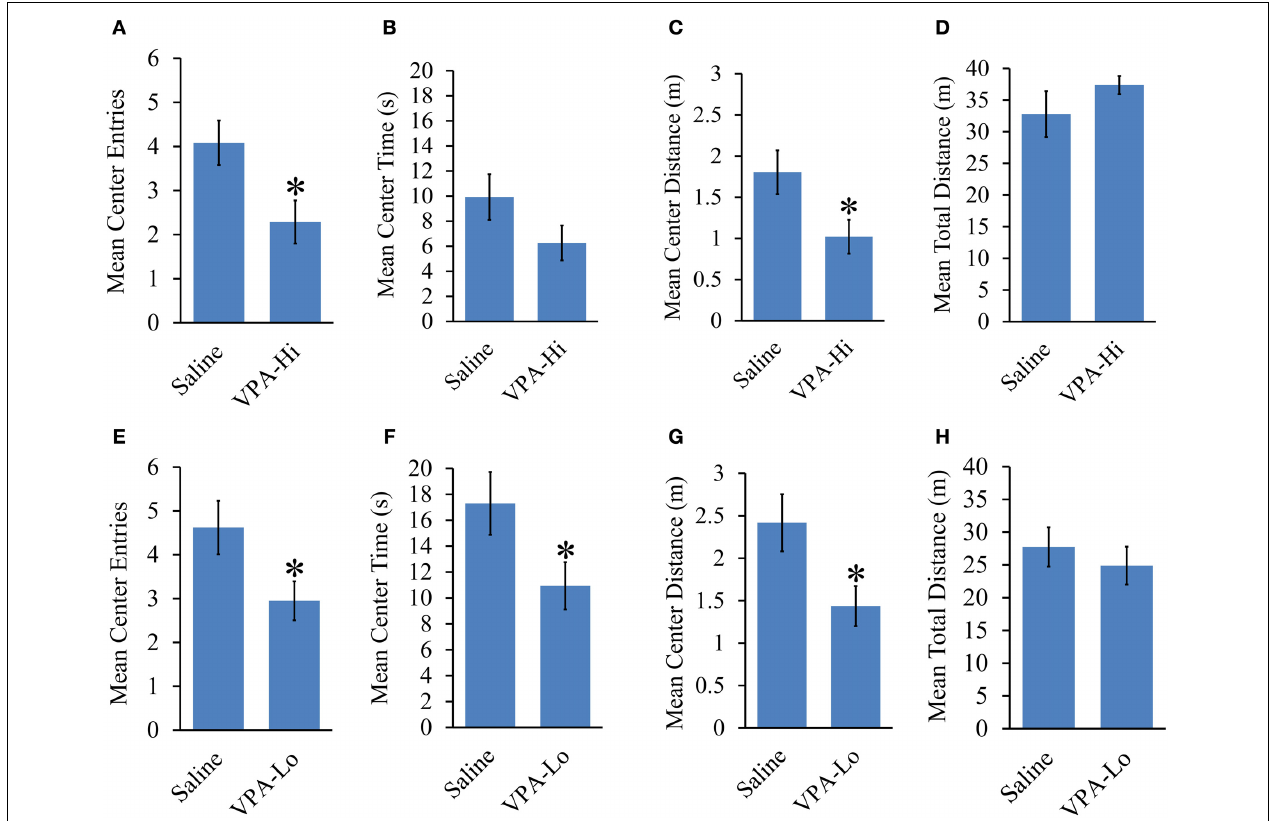
FIGURE 4 | Progeny from VPA exposed dams exhibit increased anxiety and normal locomotor behavior. Progeny from VPA-Hi dams exhibit increased anxiety in an open field as indicated by, (A) a reduced number of center entries, (B) a trend of reduced center time, (C) a reduced center distance traveled, without affecting, (D) the mean total distance traveled as compared to saline exposed animals